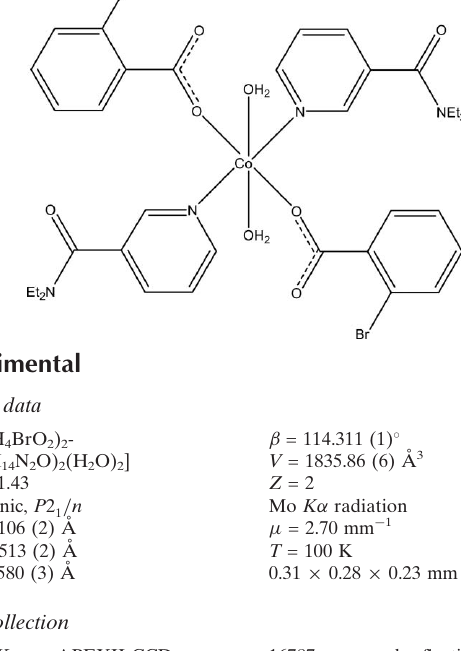
Data collection Bruker Kappa APEXII CCD area-detector diffractometer